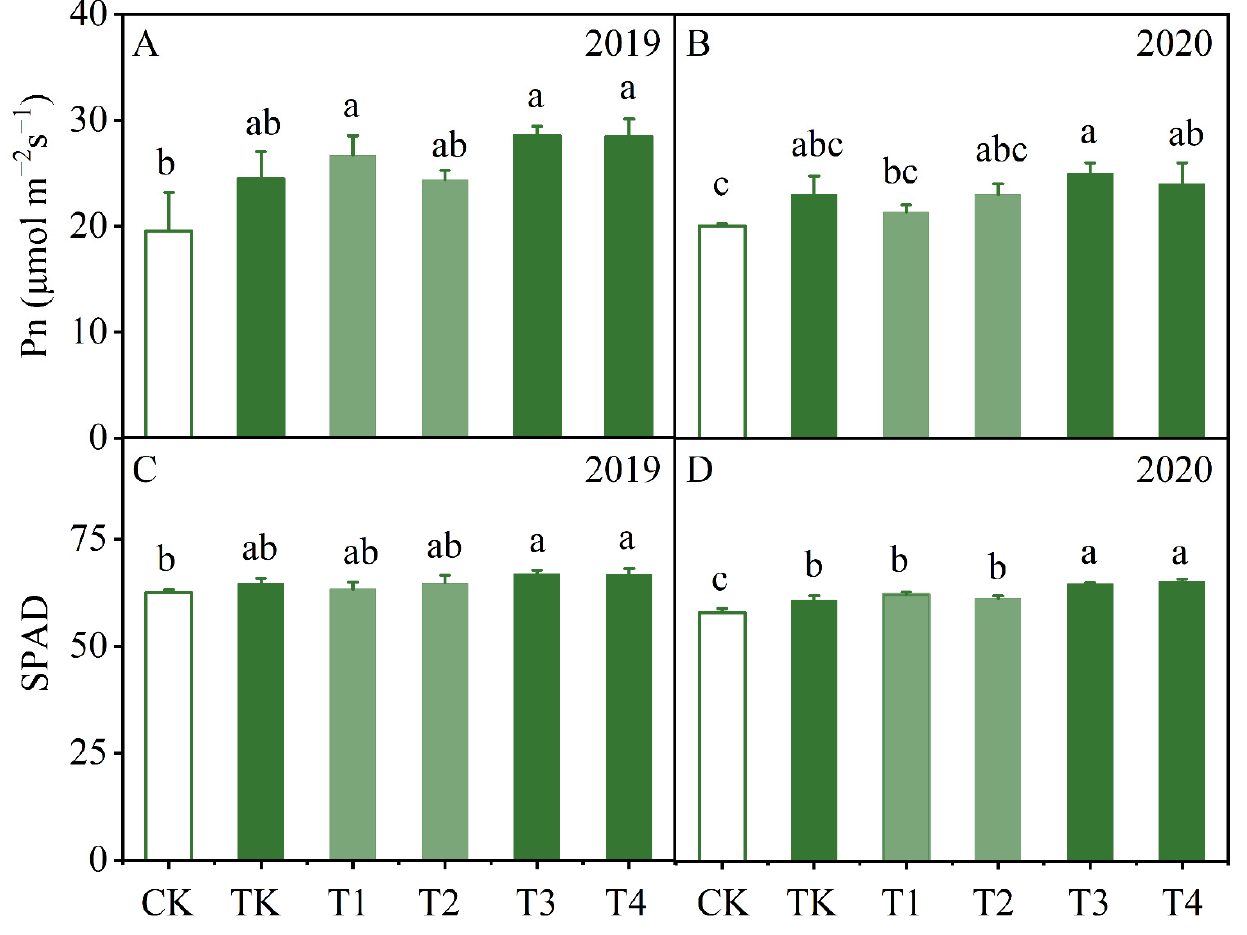
Figure 9. Net photosynthetic rate and relative chlorophyll content of ear leaf. Pn of ear leaf in 2019 ( A ) and 2020 ( B ). SPAD of ear leaf in 2019 ( C ) and 2020 ( D ). The same color in a column represents the equal dosage of EDAH. One-way ANOVA followed by Tukey test was used, and different letters above the bars indicated the significant differences ( p < 0.05) among treatments. Bars are the standard deviation of three replications.